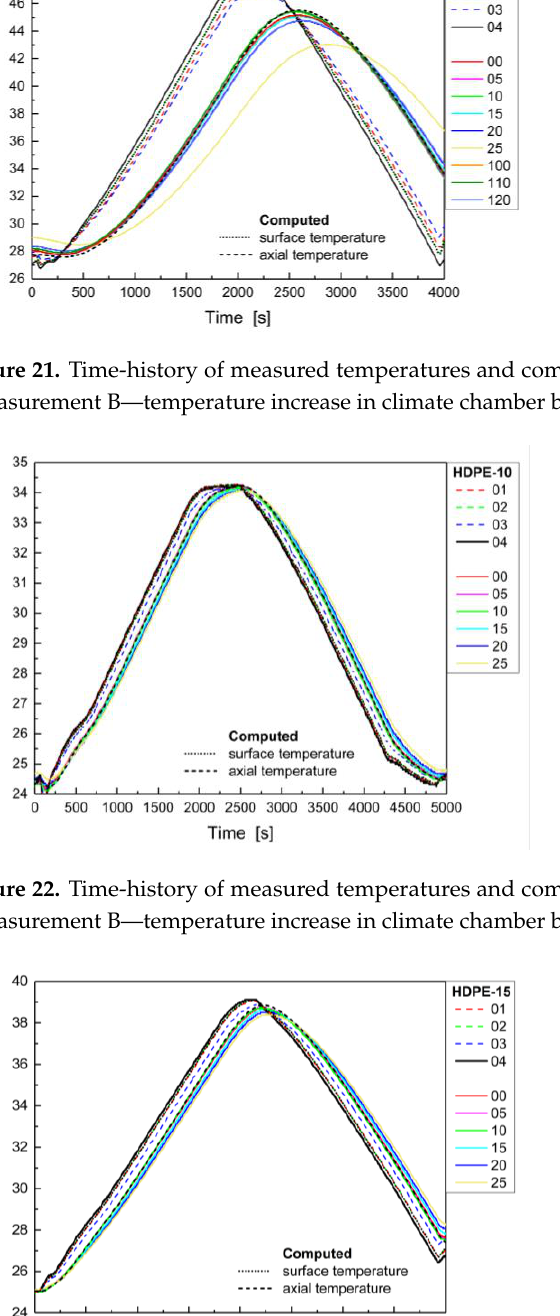
Figure 20. Time-history of measured temperatures and computed surface and axial temperatures (measurement B — temperature increase in climate chamber by 15 °C/probe 1).